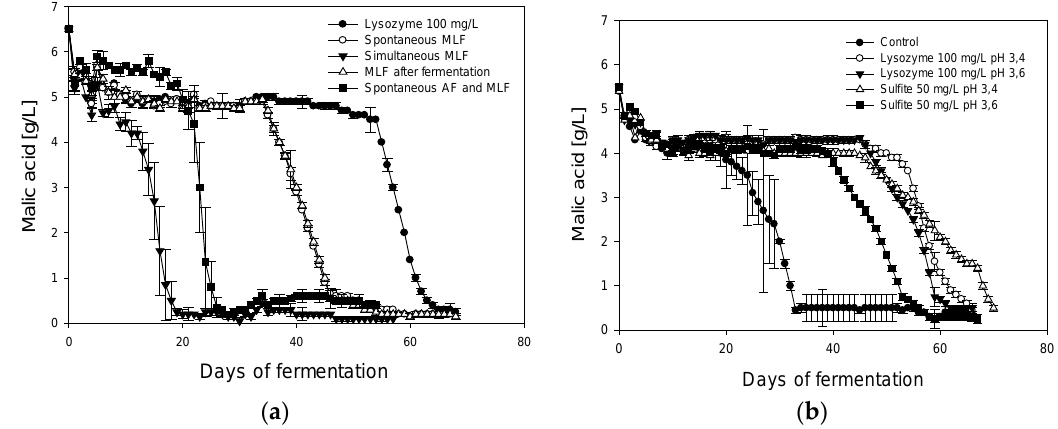
Figure 1. Delayed malolactic fermentation due to the addition of lysozyme in Chardonnay ( a ) and Pinot blanc ( b ) analyzed by FT-MIR spectroscopy (AF: alcoholic fermentation, MLF: malolactic fermentation) Error bars represent the standard deviation of experimental duplicates.